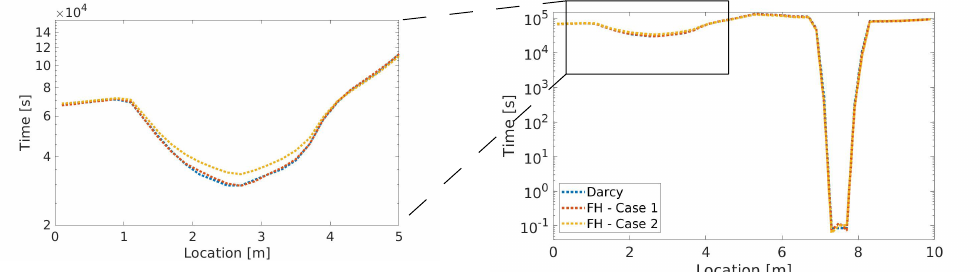
Figure 6. Breakthrough curves for Scenario (c) and the three cases on the right side, with enlargement of left macropore on the left side.